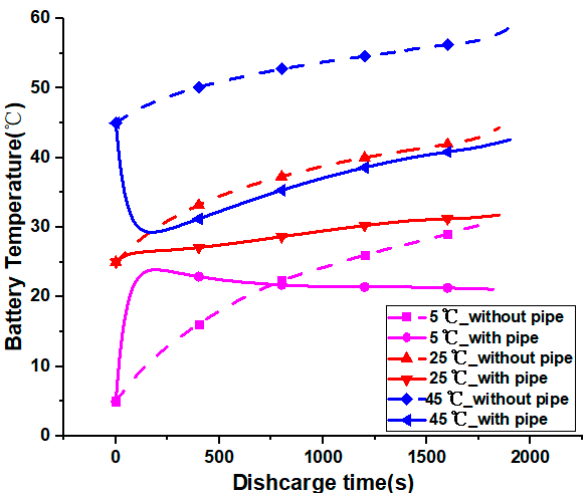
Figure 9. Variation in battery temperature with and without heat pipes with discharge depth at various ambient temperatures.